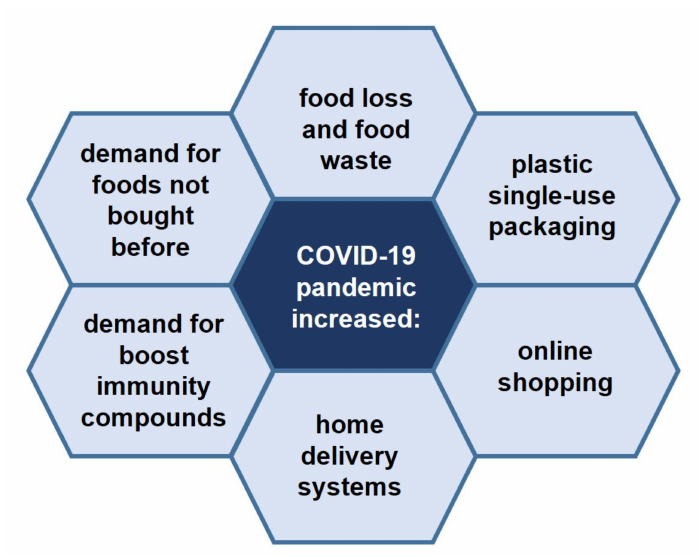
Figure 1. Main challenges during and after the COVID-19 pandemic for food